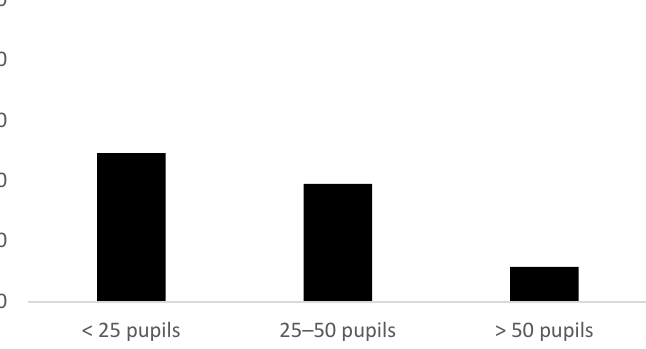
Figure 1. Group size in PA classes ( n = 69). Data from 2014.